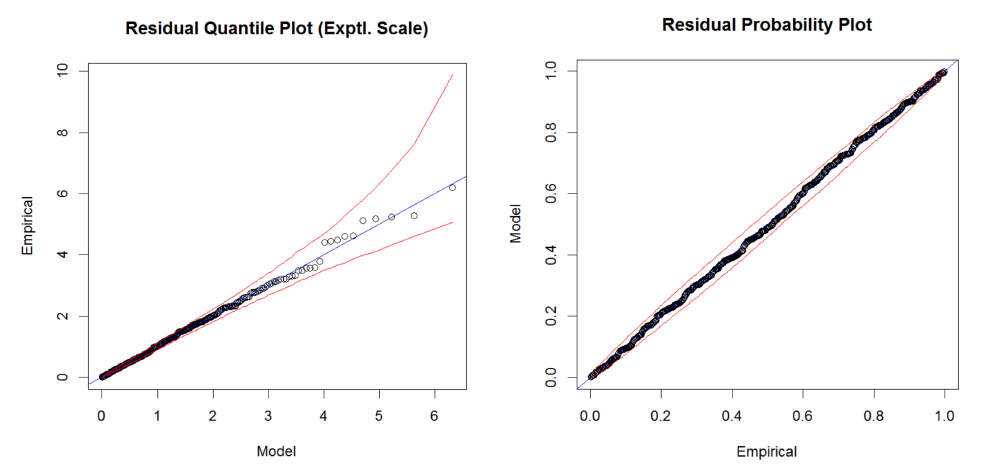
Figure A6. QQ plot ( left ) and PP plot ( right ) for the model when using the data of